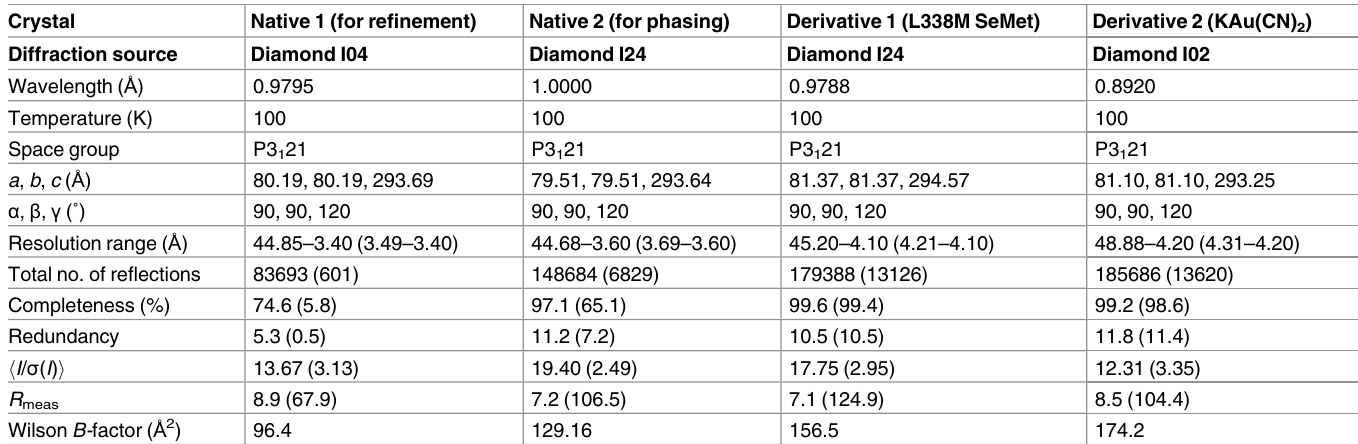
Table 2. Data collection and processing. The Values for the outer shell are given in parentheses. The native data sets were subjectedto anisotropicscal- ing and truncation (see main text for details). Without truncation h I / σ ( I ) of the native data set used for refinementfalls below2.0 betweena maximum resolution of 3.80 and 3.75 Å at an overall completeness of over 99%.